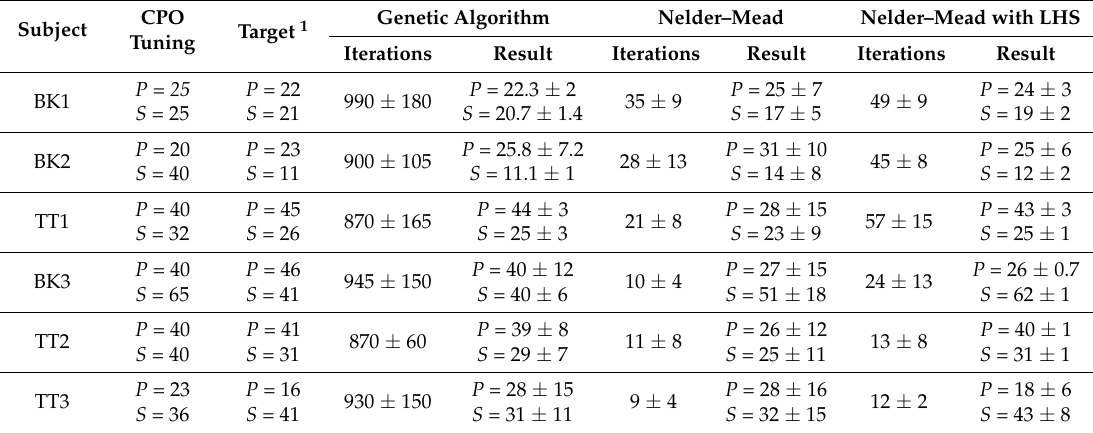
Table 1. Results of the electromyogram (EMG)-based smart search to tune powered prosthetic ankle (PPA). CPO—certified prosthetists and orthotists; LHS—Latin Hypercube Sampling.